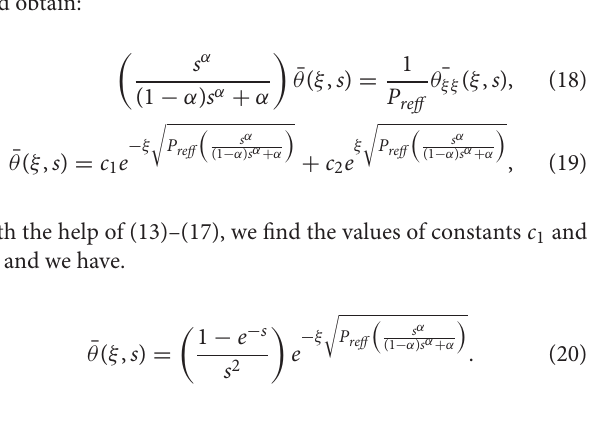
Frontiers in Physics |